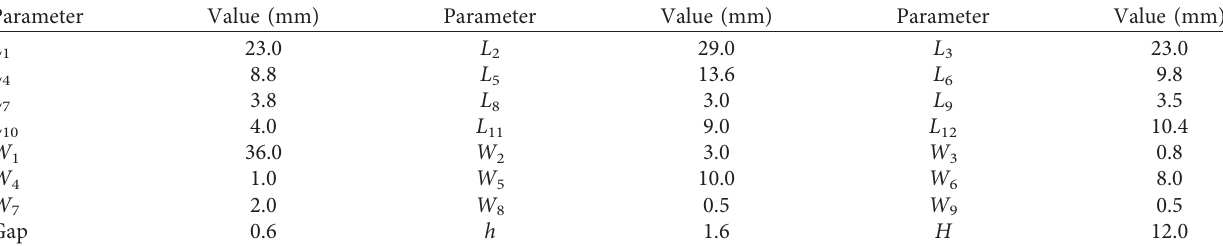
Figure 1: Geometry of the proposed antenna: (a) perspective view, (b) the radiator, (c) the balun structure, and (d) side view. Table 1: Dimensions of the proposed